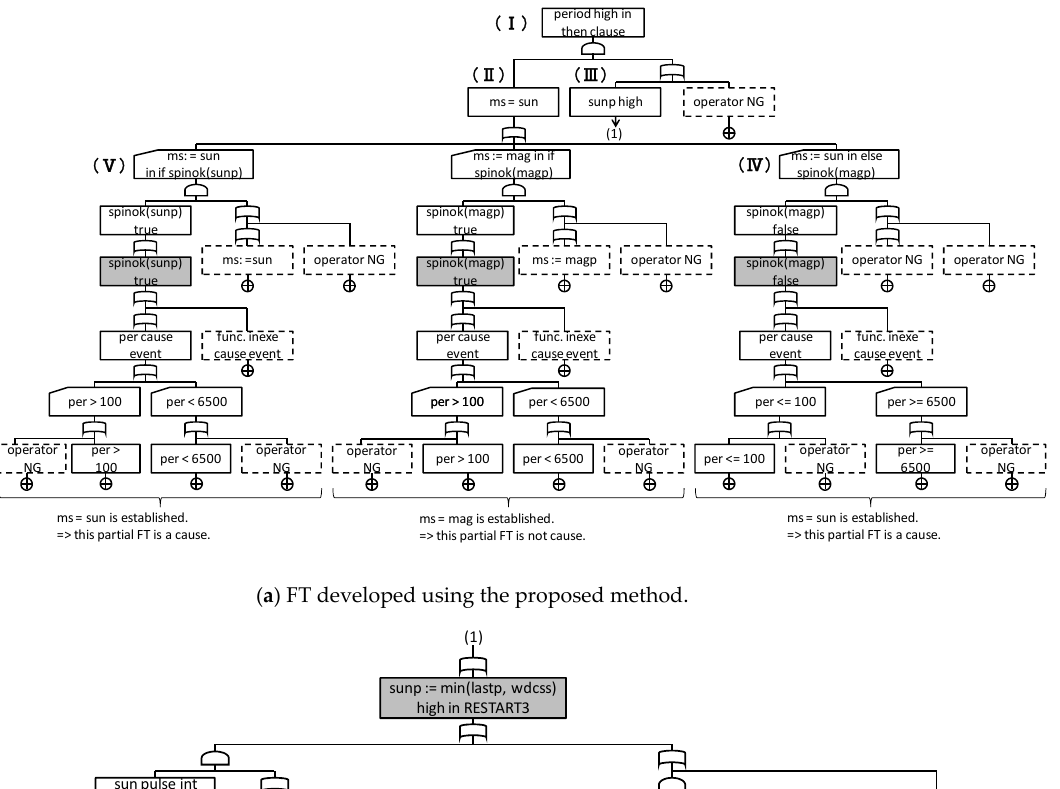
Figure 17. FT developed by Leveson.